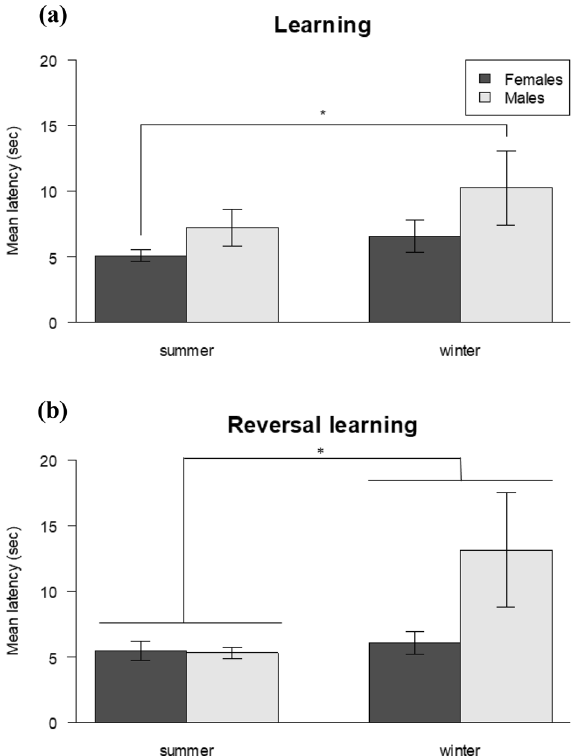
Figure 1. Mean latency ± SEM (in seconds) for all trials needed to reach the learning criterion by season and sex. Males tested in winter showed longer latencies both during the ( a ) the learning task (N females = 41; N males = 46) and ( b ) the reversal learning task (N females = 38; N males = 40). Post hoc t test with Tukey correction, *P ≤